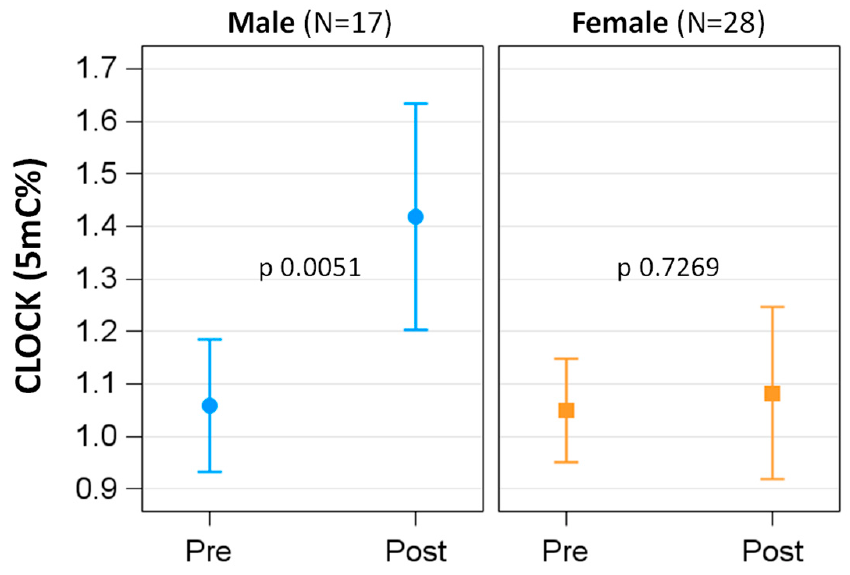
Figure 1. DNA methylation level of the clock gene in males and females: pre- vs. post-BWRP com- parisons.